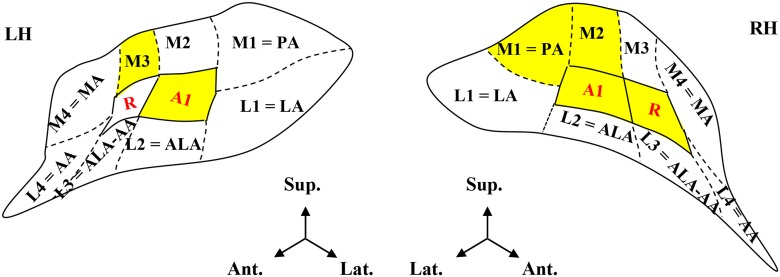
Early-stage auditory areas with repetition suppression effect, i. e. significant difference between the REP and CTRL conditions during the plateau phase (gray shading).